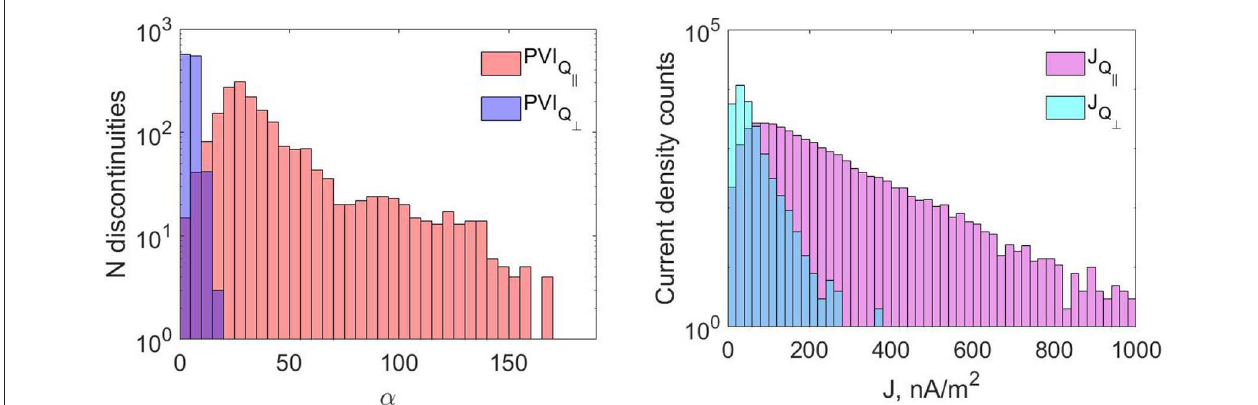
FIGURE 4 | Current magnitude from curlometer vs all PVI values (gray) in the case of Q || MSH. The black dots correspond to PVI conditioned for magnetic shear larger than 100 ◦ . The red dashed line represents the correlation with coefficient 0.7, between the current and the conditioned PVI.